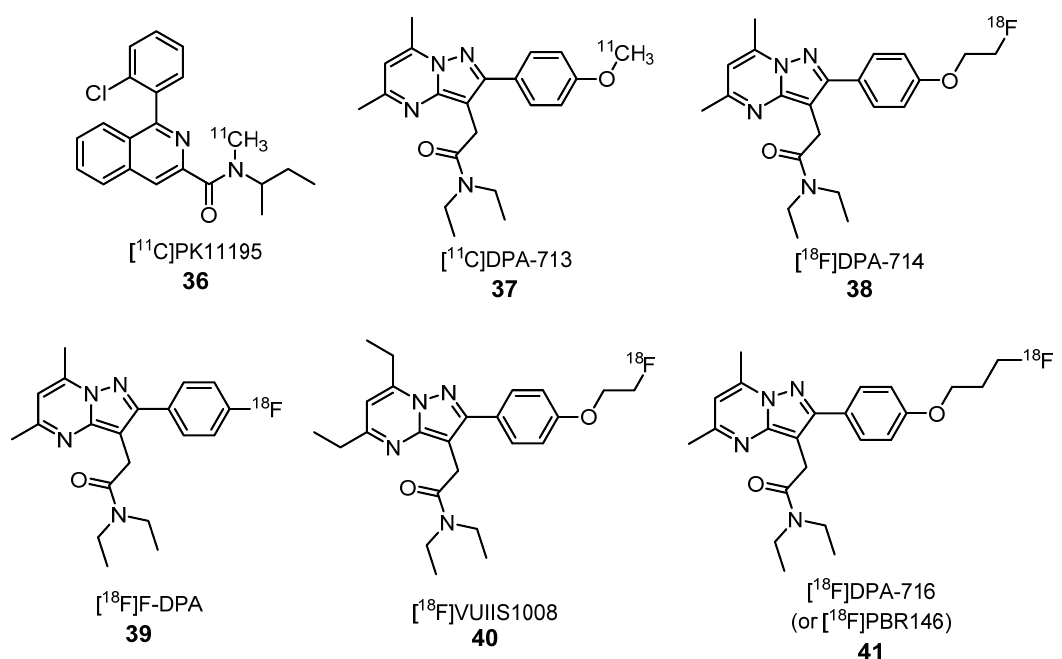
Figure 15. [ 11 C]PK11195 ( 36 ) and pyrazolopyrimidine-derived radiotracers 37 – 41 for translocator protein (TSPO) PET imaging [72–82].